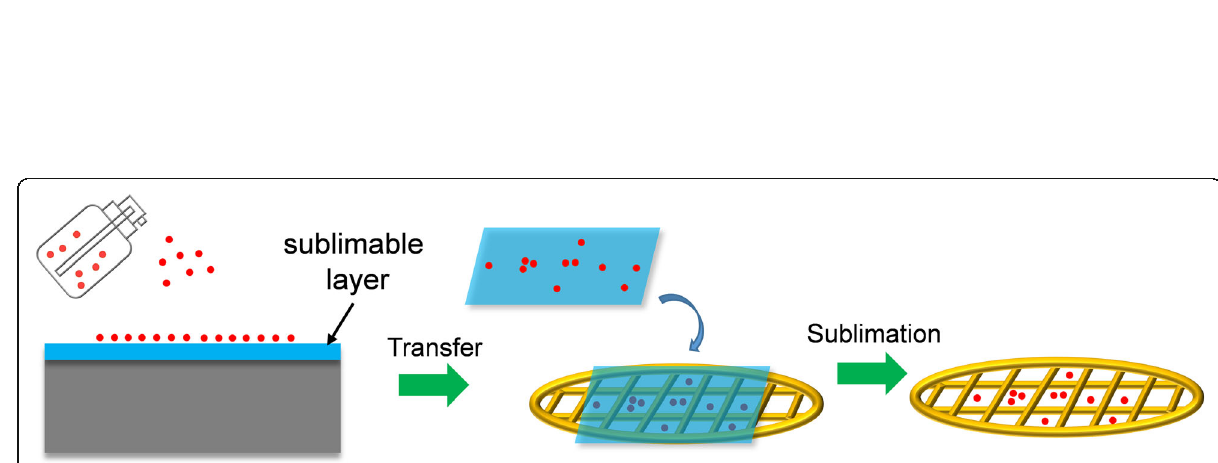
Fig. 2 Schematic diagram of TEM sample preparation. Nanomaterials were sprayed onto sublimable layer and transferred on the TEM grid, then place the sample in a vacuum to sublimate naphthalene